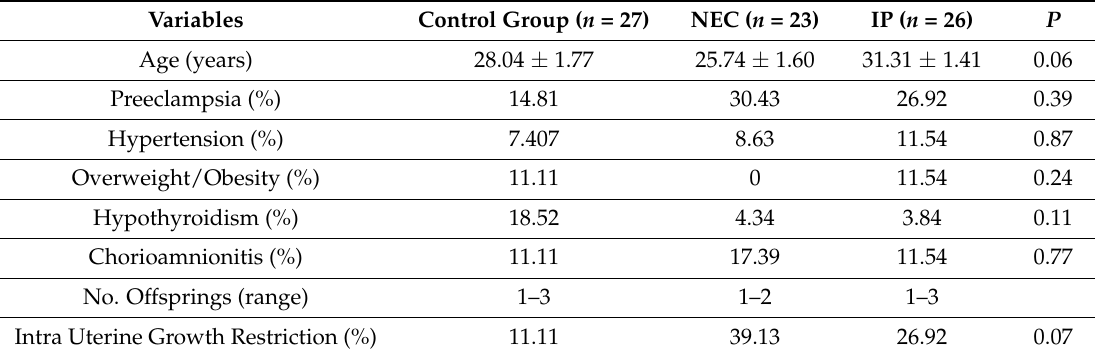
Table 1. Clinical and demographic characteristics of the maternal population.